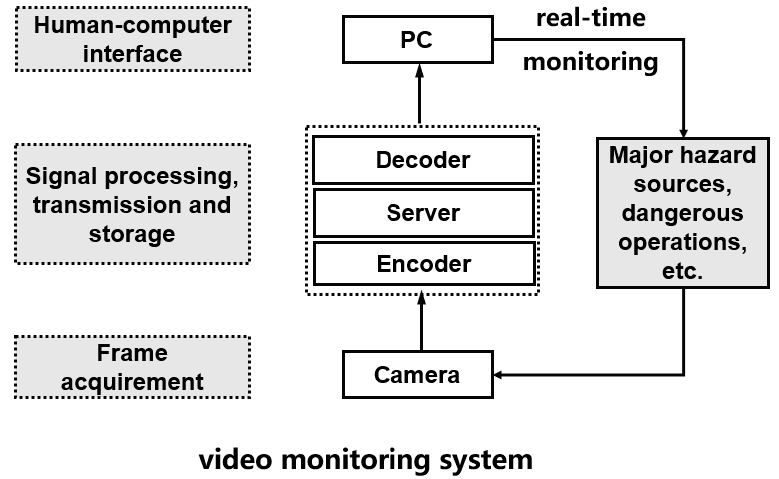
Figure 13. Flowchart of the video monitoring system.